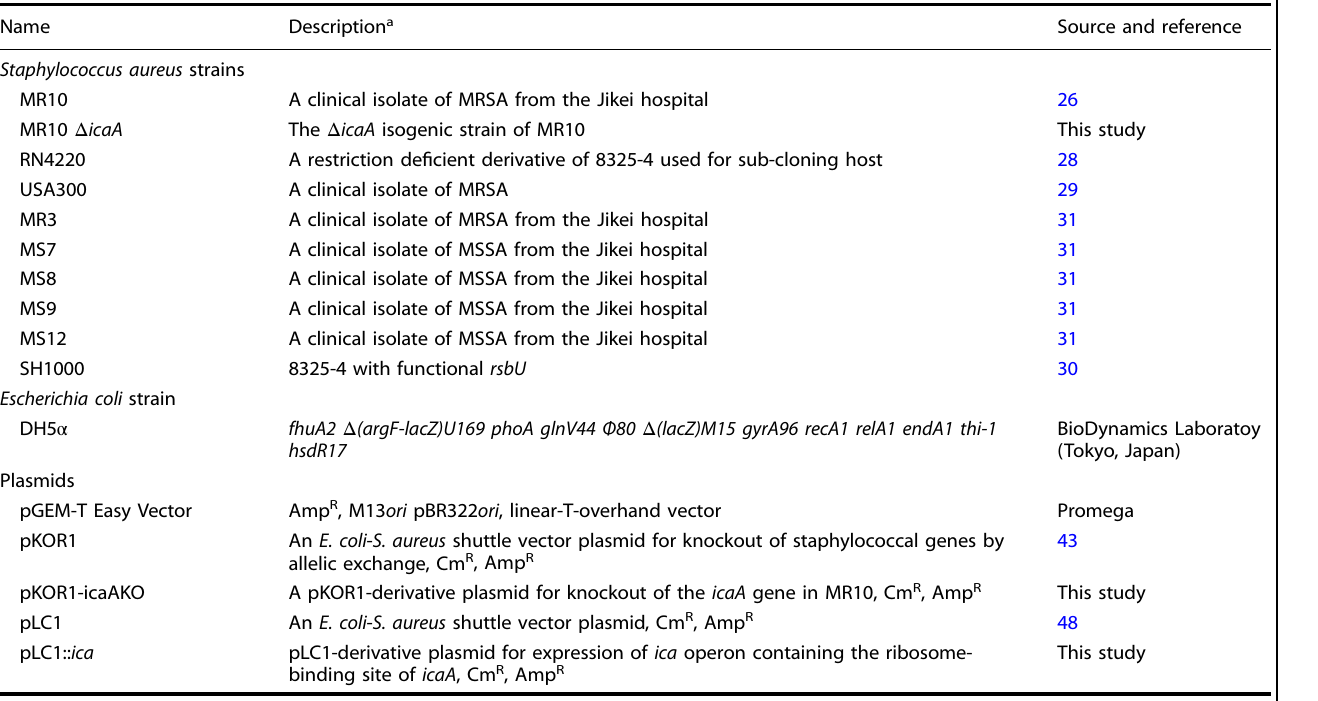
Table 1. Bacterial strains and plasmids used in this